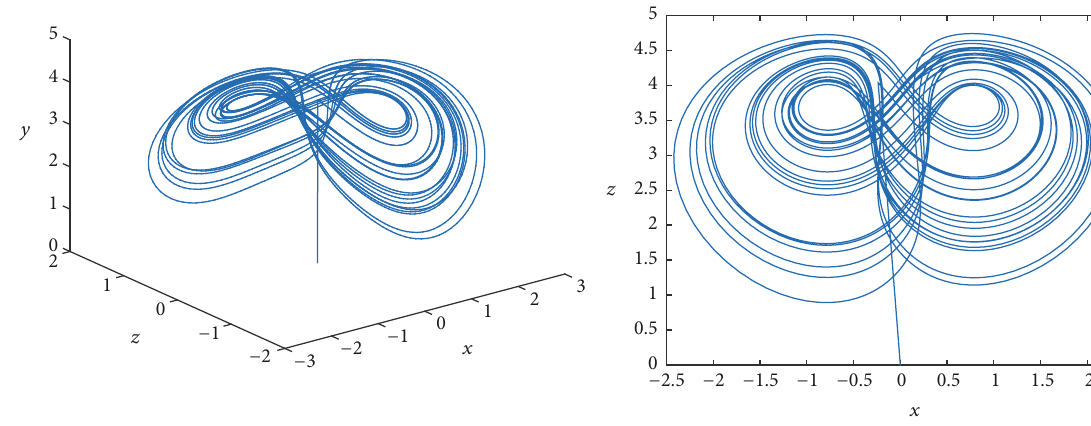
Figure 1: Chaotic attractors of system